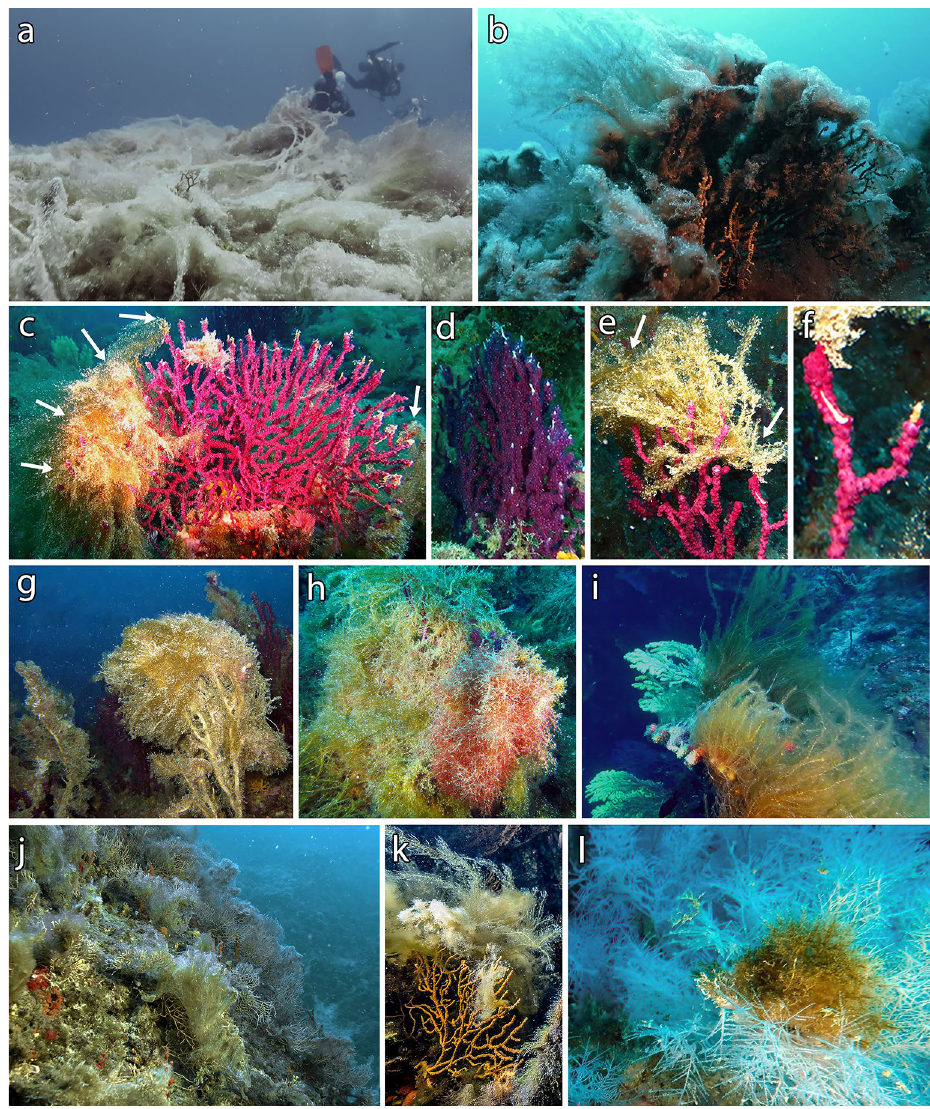
Figure 3. Effects of global warming on coral forests at Tremiti Islands. ( a ) Massive mucilaginous aggregates covering a forest of Paramuricea clavata (2017); ( b ) Colony of P. clavata with mucilage and Sporochnus pedunculatus (2018); ( c – e ) Colonies with extremities necrosis and S. pedunculatus epibiosis (arrows) (2019); ( f ) Detail of extremities lesion and necrosis on; ( g ) Dead colony covered by epibionts (2019); ( h ) Living colony completely covered by macroalgae (2019); ( i ) Living colonies on the top of a rocky wall, with S. pedunculatus growing on the side of the corals exposed to light (2019); ( j ) Forest of Eunicella cavolini affected by mucilage and S. pedunculatus , with ( k ) detail of one colony (2018); ( l ) Macroalgal epibionts on Antipathella subpinnata